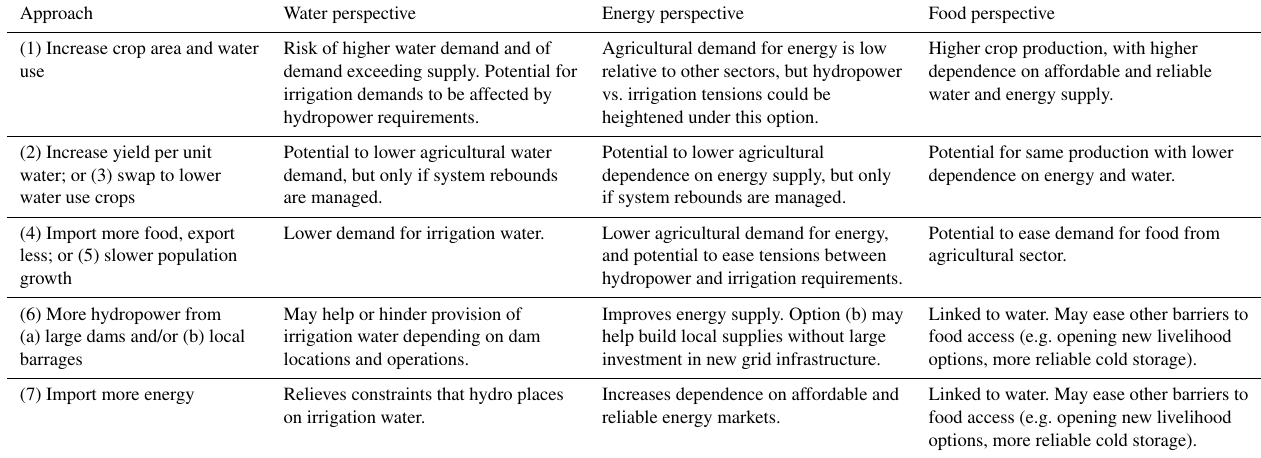
Table 1. Material consequences of five categories of food-water activities and two energy options. Consequences are relative to Kirby et al. (2017) “yield only” scenario with median population